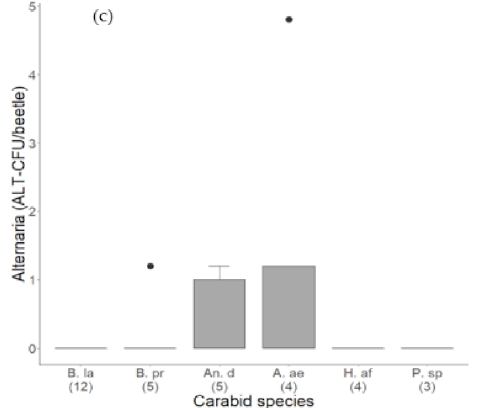
Figure 2. Load of ( a ) Total fungi (TOTAL-CFU/beetle), ( b ) Fusarium fungi (FUS-CFU), and ( c ) Alternaria fungi (ALT-CFU), detected on the body of carabid beetles with a culture-dependent method. Number of individuals per beetle species presented in brackets. Carabid species are sorted from lightest to the heaviest (median body weight). Species code according to Table 1 (abbreviations short). Black dots in the boxplots are outliers or only one observation per carabid species in ( b , c ).